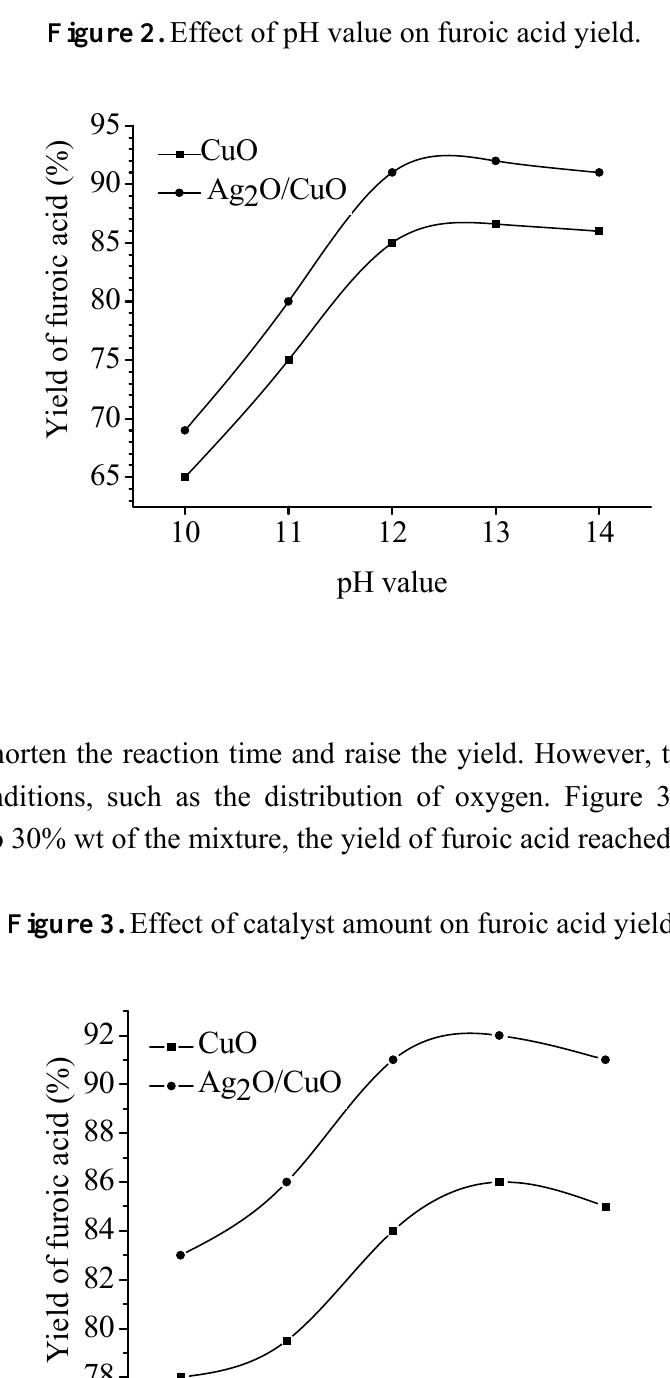
Figure 2. Effect of pH value on furoic acid yield.